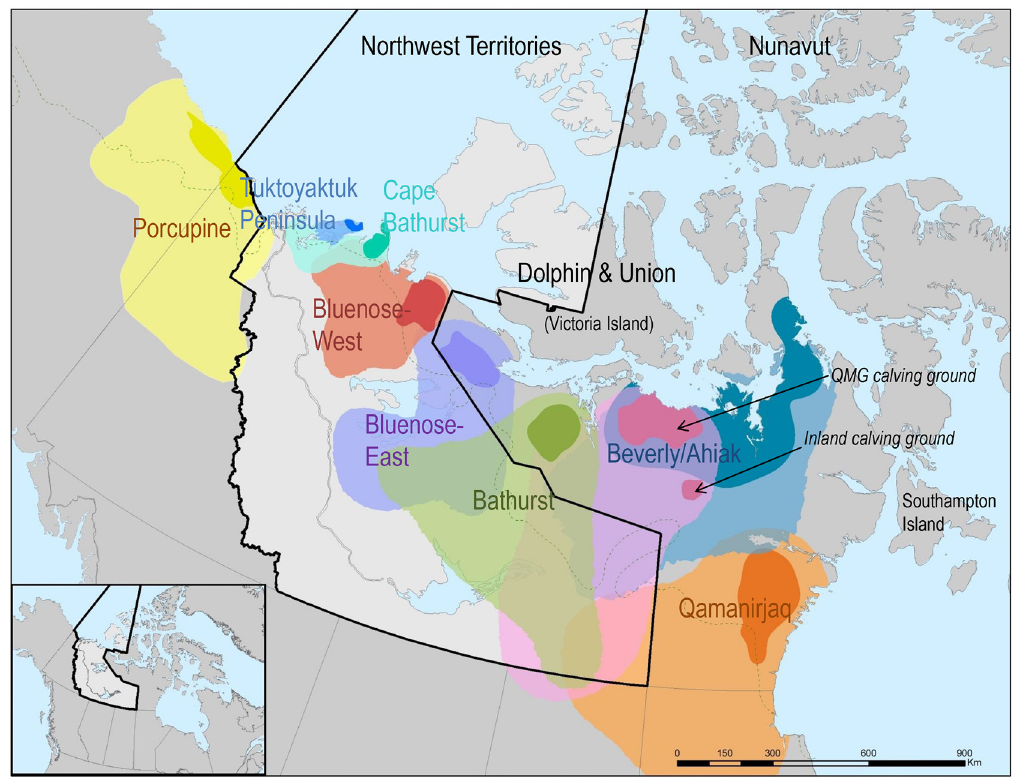
Figure 1. Calving grounds of North American barren-ground caribou subpopulations. Darker shades denote areas used by greater numbers of caribou. There are two major calving grounds within the range of the Beverly and Ahiak subpopulations: the Queen Maud Gulf (QMG) calving ground and the Inland Beverly calving ground. The dark blue shaded area encompasses several calving areas based on 95% utilization distribution for calving caribou across years. The mainland subpopulations from this study include Bluenose-Ease, Bathurst, Beverly/Ahiak (which may include either Beverly or Ahiak caribou, or a mixture of both), and Qamanirjuaq; island subpopulations from this study include Dolphin and Union and Southampton Island. This map was modified from a map of mainland subpopulation calving grounds provided by B. Fournier, Department of Environment and Natural Resources, Gov- ernment of Northwest